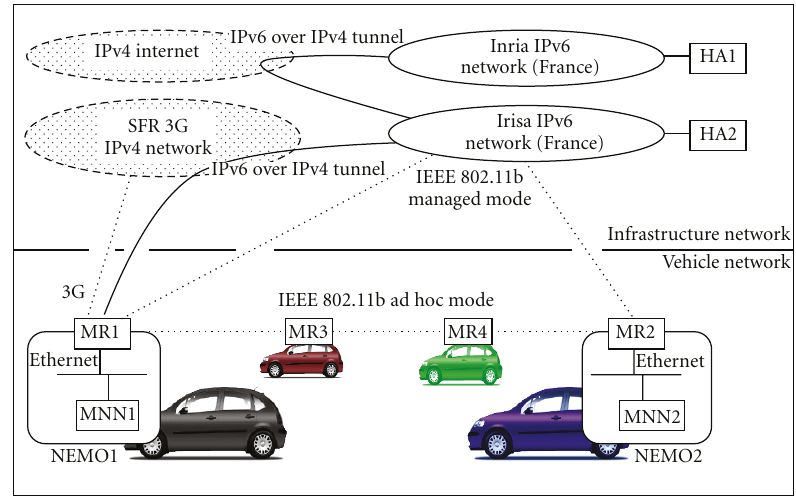
Figure 3: Topology of the vehicular network and Internet